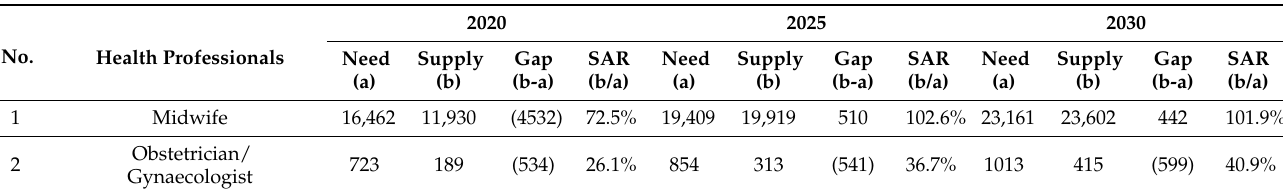
Table 3. Gap analysis between needs-based requirements and anticipated